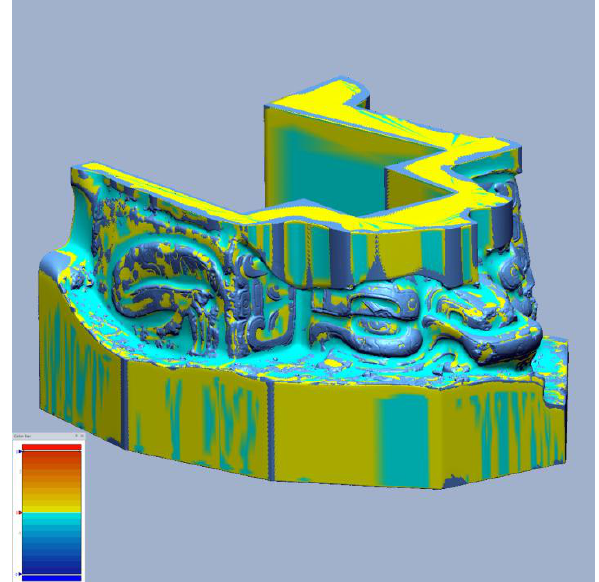
Figure 6. Deviation between Hi-poly mesh and Subdivisio surface valued using Accuracy Analyzer.